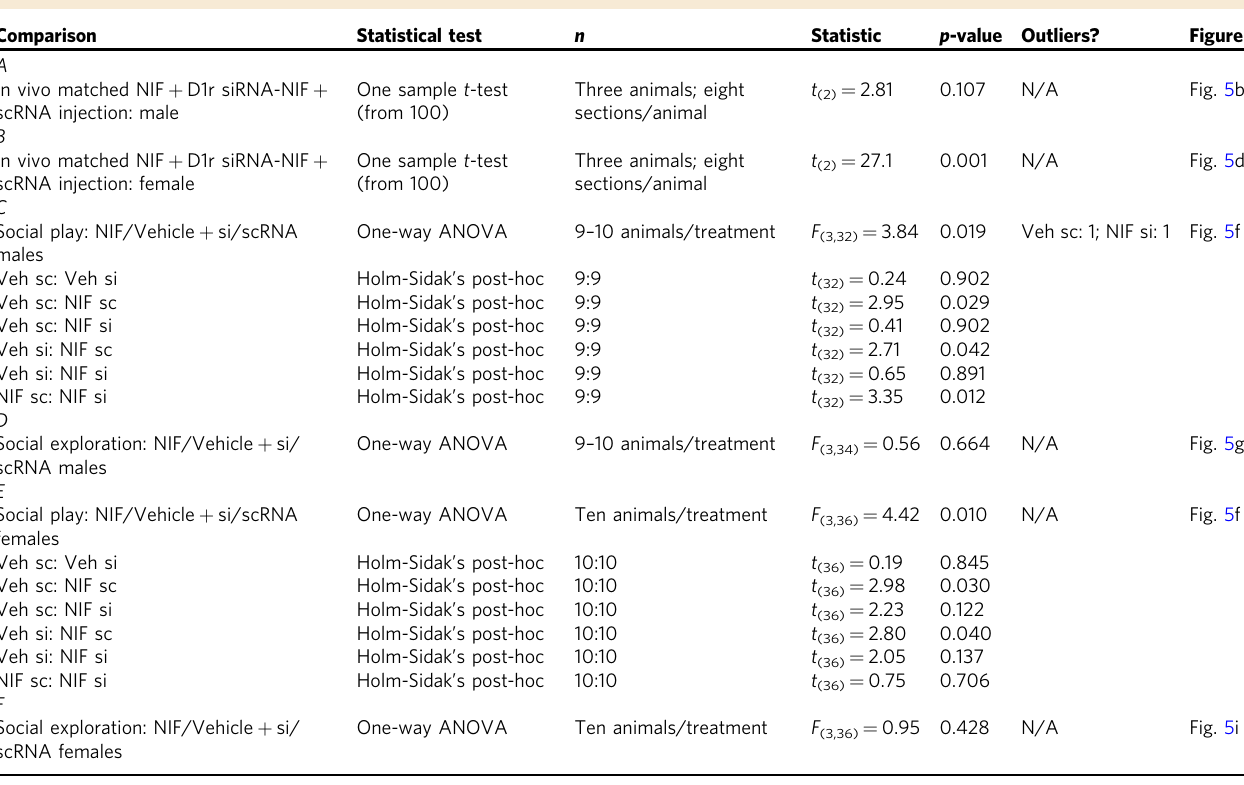
Table 5 Detailed statistics corresponding with Fig. 5 Comparison Statistical